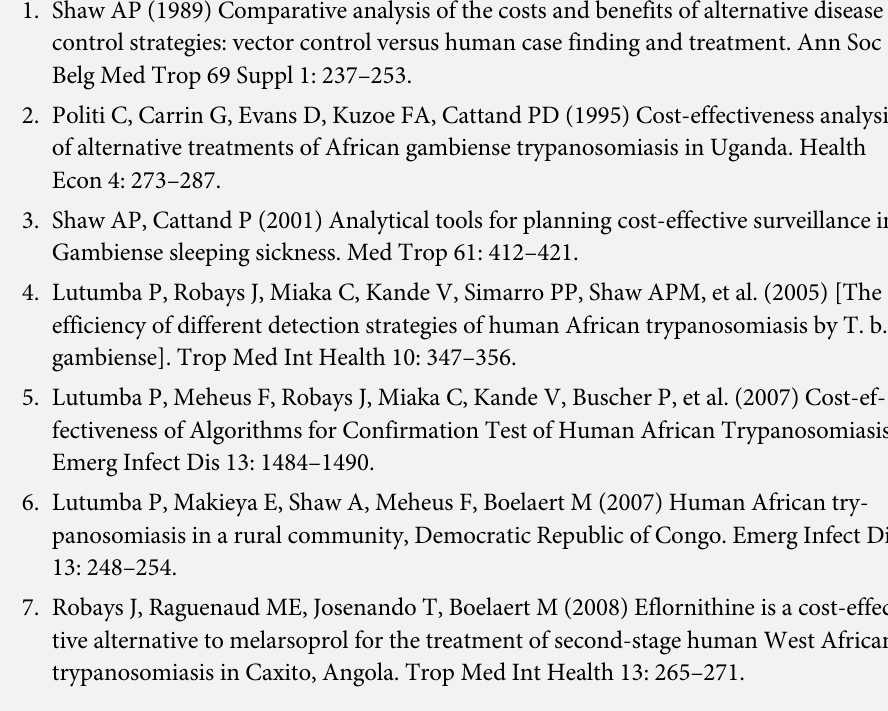
Box 2. Key Papers in Economic Evaluation of HAT